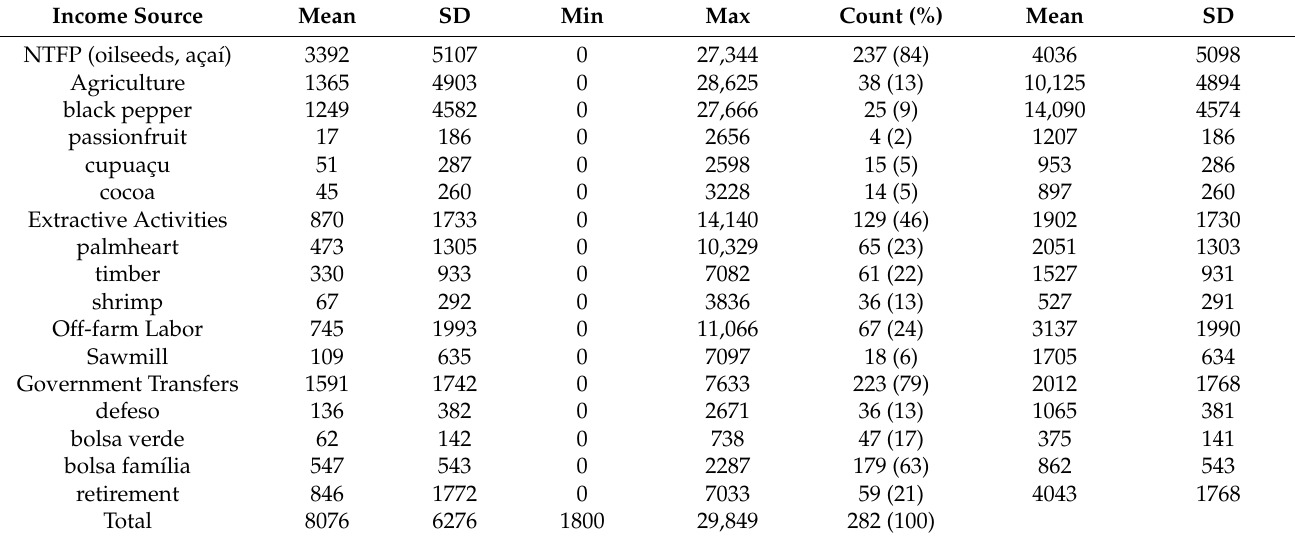
Table 3. Summary of annual income by source in US $, n = 282.